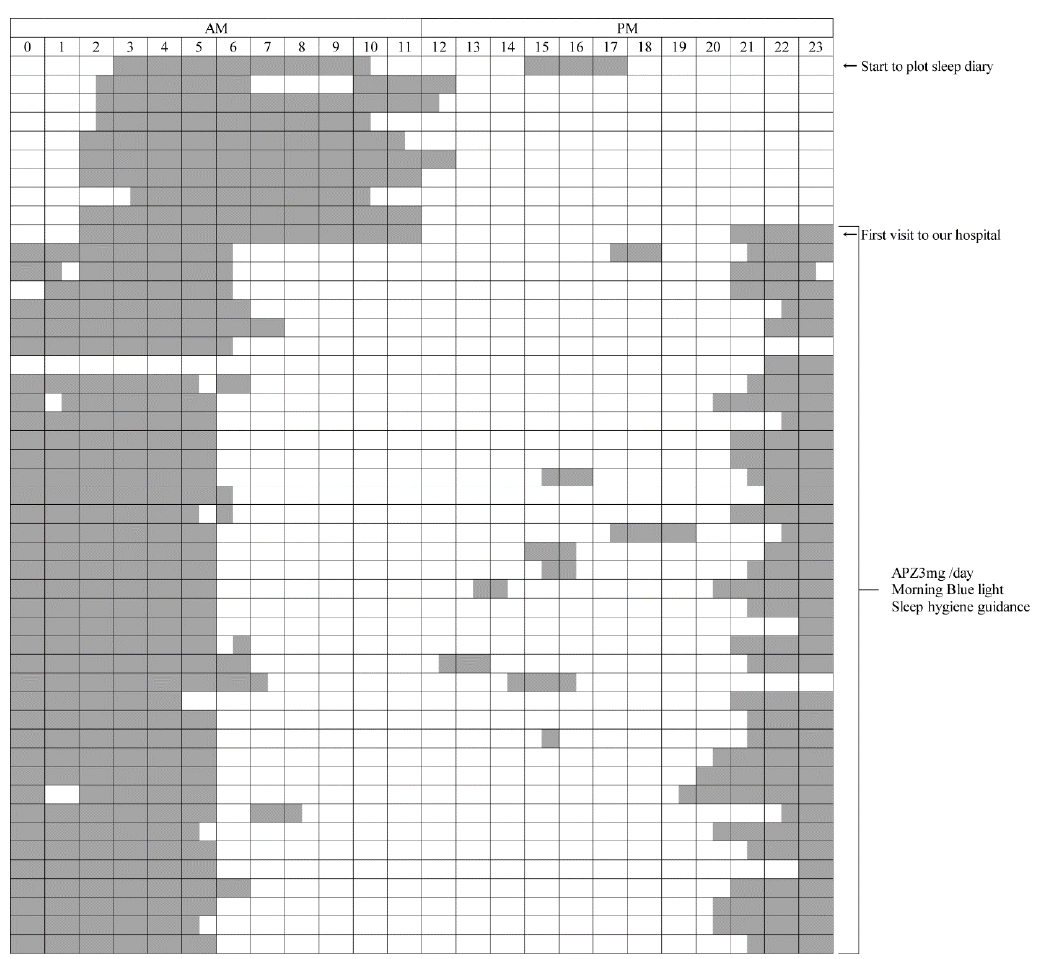
Figure 2. Sleep diary.